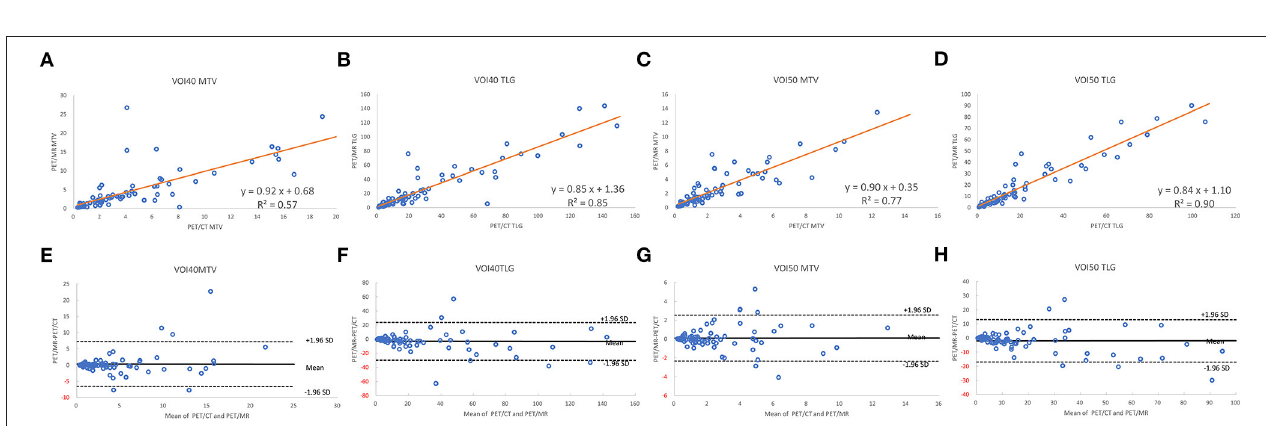
FIGURE 3 | Scatter diagram with regression line and Bland-Altman plots of PET-CT and PET-MR for MTV and TLG of VOI40 (A,B,E,F) and VOI50 (C,D,G,H) .